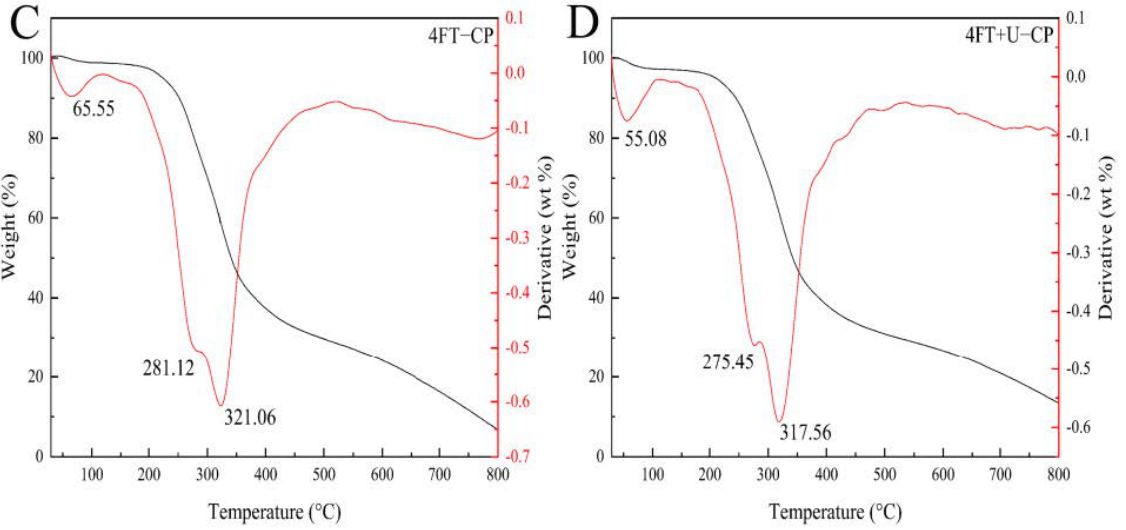
Figure 3. TGA of S-CP ( A ), HPCD-CP ( B ), 4FT-CP ( C ), and 4FT+U-CP ( D ) (protein concentration Figure 3. TGA of S−CP ( A ), HPCD−CP ( B ), 4FT−CP ( C ), and 4FT+U−CP ( D ) (protein concentration used was 1 used was 1 mg/mL).